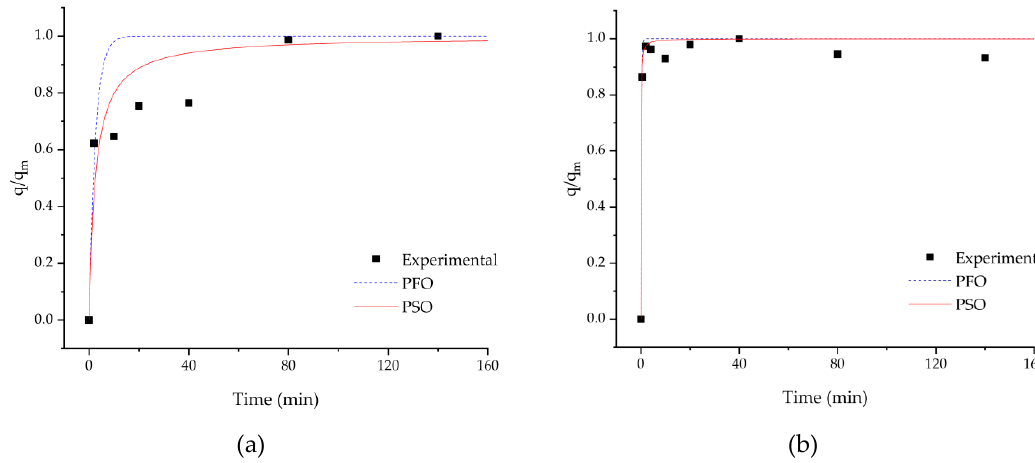
Figure 8. Adsorption kinetics of a 4 mg / L solution represented by normalized adsorption capacity: ( a ) pH = 3 and ( b ) 6.4.